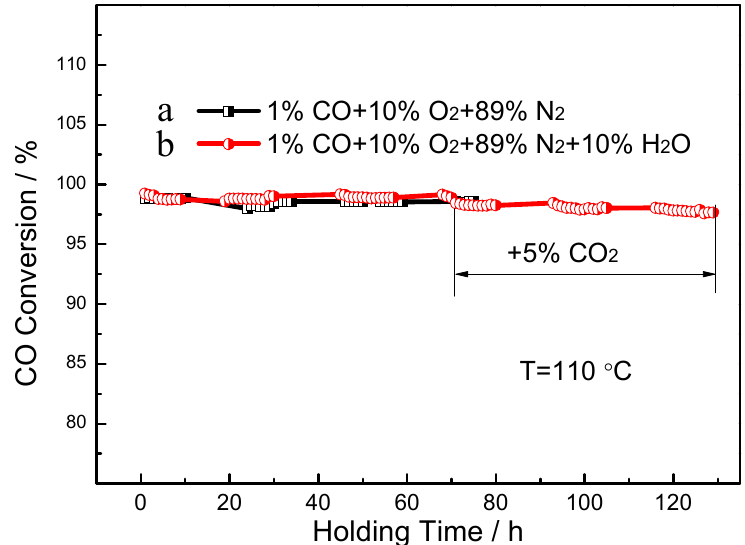
Figure 5. ( a ) CO conversion as a function of reaction temperature over the CeO 2 , Pt 0.1 / CeO 2 , Pt 0.3 / CeO 2 and Pt 0.5 / CeO 2 catalysts; ( b ) the Pt 0.3 / CeO 2 catalyst prepared from dealloyed Al 91.7 Ce 8 Pt 0.3 calcined at different temperatures. The inset image of ( a ) is the complete conversion curve for CeO 2 .